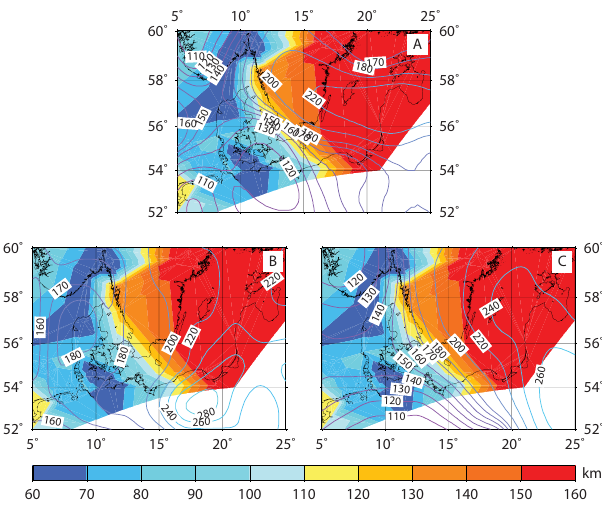
Figure 5. Comparison of calculated regional lithospheric thickness variations with the RSES ice model (filled contour maps) to seis- mically and thermally derived lithospheric thicknesses (solid lines) by (A) Tesauro et al. (2009), (B) Hamza and Vieira (2012) and (C) Priestley and McKenzie (2013). Contour maps are drawn with the GMT pscontour